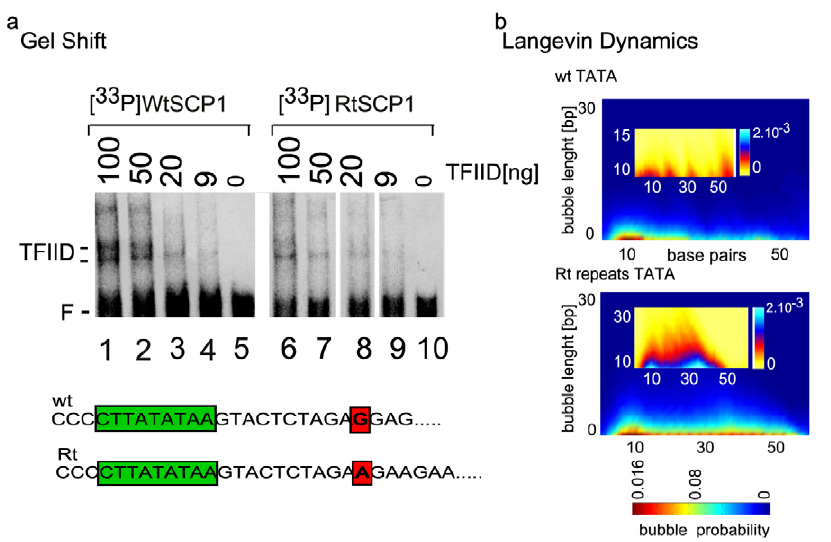
Figure 4. Effect of TRS on TFIID-TATA box DNA binding and local DNA dynamics. a) Band shift titration reactions received [ 33 P]-labeled, double-stranded oligonucleotides containing the 60 bp long SCP1 TATA box sequence (10 nm): RtSCP1-mutant SCP1 variant contains 15 (GAA.TTC) repeats downstream of the TATA box; Wt SCP1-wild type SCP1 promoter sequence as indicated at the top of the panel. All reactions are conducted at 370C and identical buffer conditions. The reactions in lanes 1–4 and 6–9 received different amount of purified human TFIID complex as indicated at the top of the lanes. The reactions in lanes 5 and 10 did not receive TFIID. The positions of the free DNA (F), and TFIID complexes (TFIID) are indicated on the right. The sequence of the Wt SCP1 oligo and the mutant Rt SCP1 is shown below the panel. The TATA box sequence is underlined. b) LMDs simulations of the collective DNA openings in Wt SCP1 and RtSCP1 sequences. The top panel- wSCP1 bubble probability; bottom panel- Rt SCP1 bubble probability. The insets (yellow) -the probabilities (colored axis on the left: 0–2.10 2 3 ) for bubbles over 10 bp; y-axis - length of the bubbles in bp; x-axis - number of the base pair.